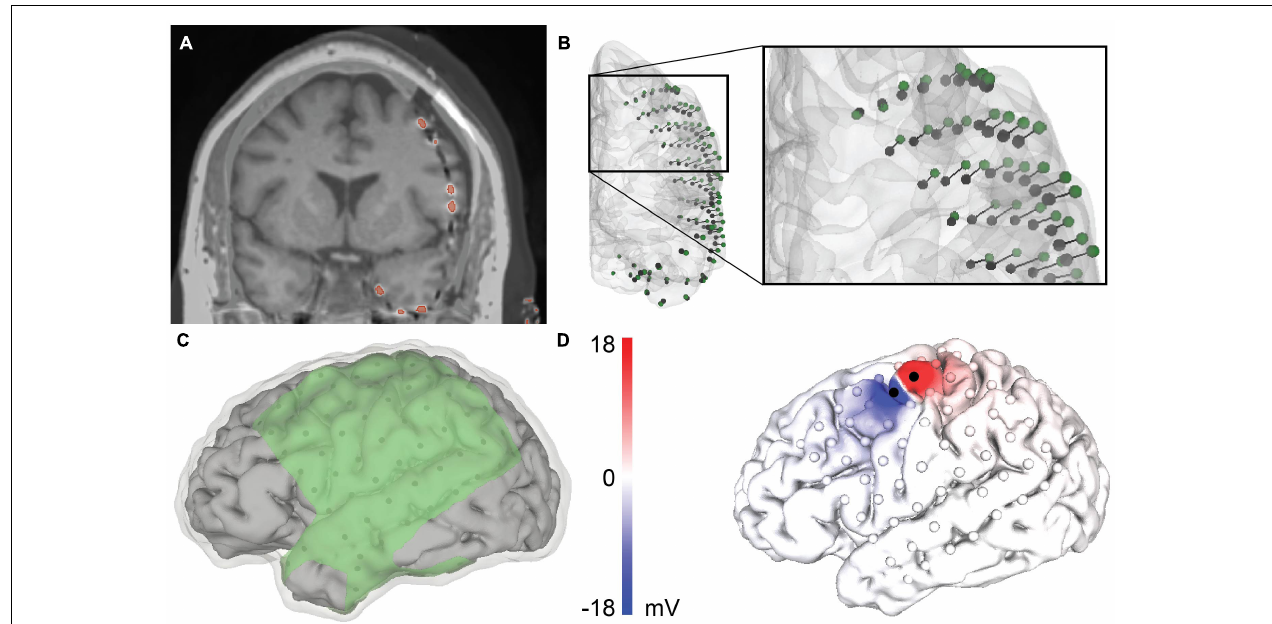
FIGURE 1 | Patient-specific modeling pipeline for a representative patient, patient 4. (A) Merged co-registered magnetic resonance imaging (MRI) and computed tomography (CT). The thresholded electrodes from the CT are shown in red. Due to brain shift, some electrodes appear to be inside the brain and require projection to the closed gray matter surface. (B) Anterior view of the rigid electrode centroids (black) with a vector to the projected Hermes localization (green). (C) The geometry of the volumetric mesh: cerebral spinal fluid (CSF) (transparent), gray matter (gray), and insulating sheet (green). The electrodes are shown in black on the underside of the insulating sheet. (D) The predicted voltage on the cortical surface during bipolar stimulation between the black electrodes.